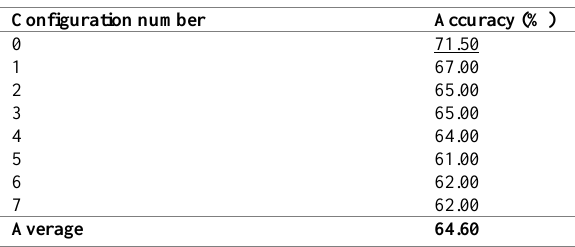
Table 6. Assessment